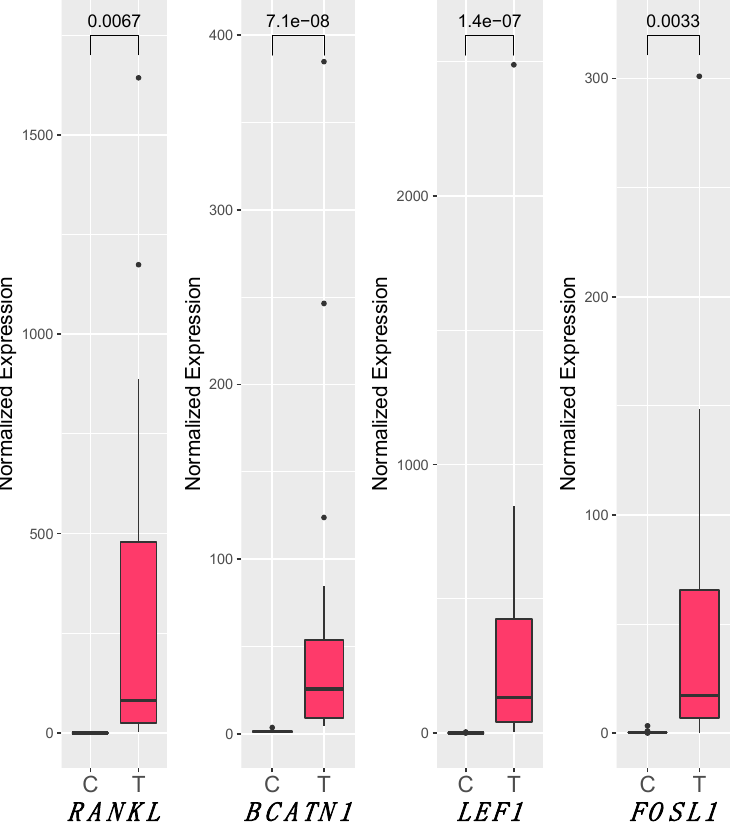
Figure 3. Box plot of RANKL , LEF1 , BCATN1 , and FOSL1 gene expression. The statistical significance (P < 0.05) of median differences was assessed through Mann–Whitney U test after normalizing expression levels with those of the reference B2M . The statistically significant values are shown above the horizontal bar above the horizontal bar on the upper part of the graph (“e” stands for exponential of ten). C: control group; E6+: samples expressing E6 gene; E6 − : samples not expressing E6.